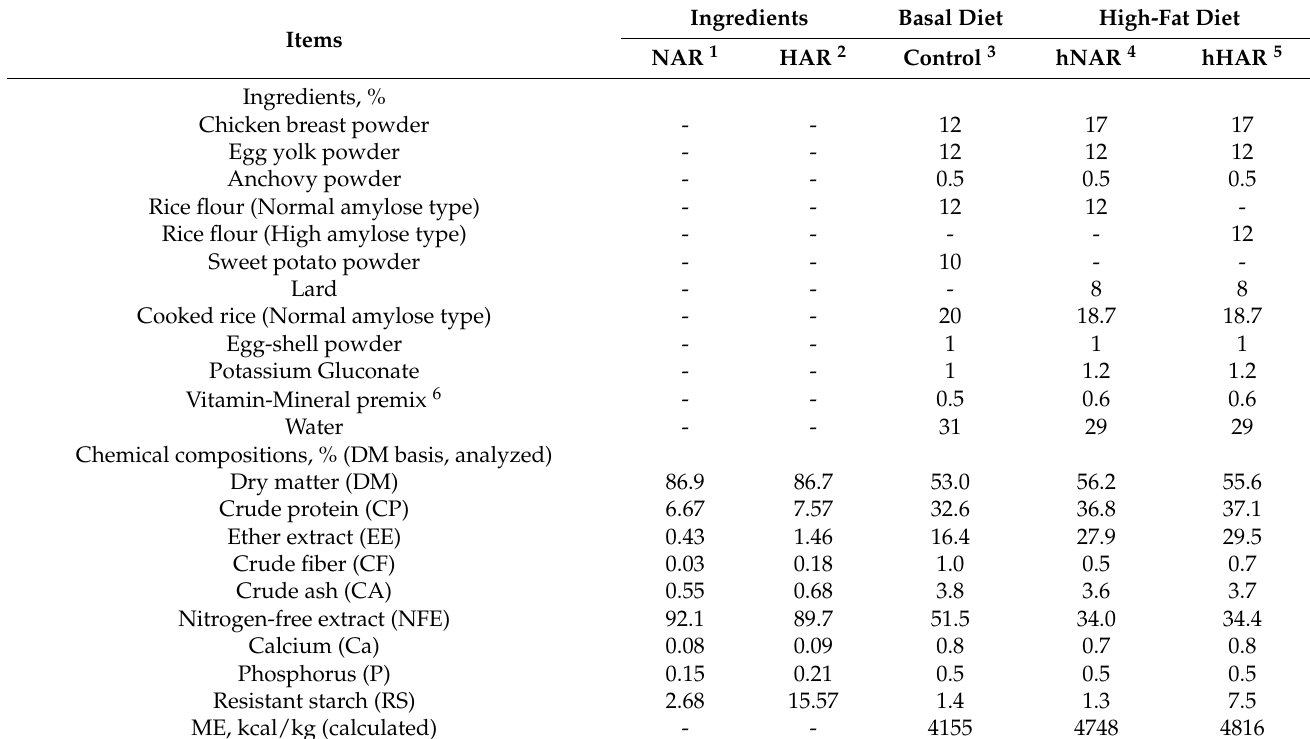
Table 1. Formulation and chemical composition of experimental diets (Exp.